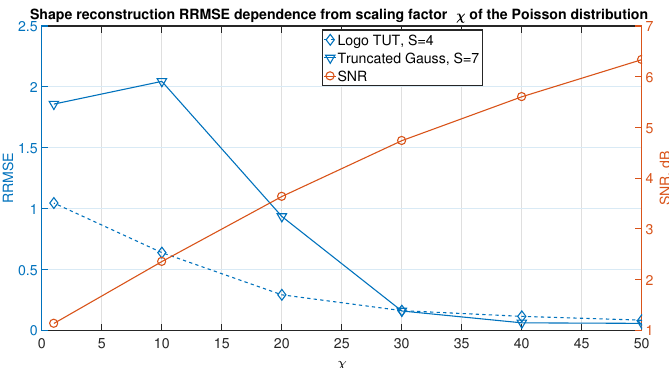
Figure 3. RRMSE and SNR as functions of the parameter χ of the Poissonian distribution: solid triangles and dashed diamonds curves (blue in color images) show RRMSE for the truncated Gaussian and logo TUT objects, respectively (left y-axis); solid circle curve (orange) shows SNR of the observations (right y-axis).